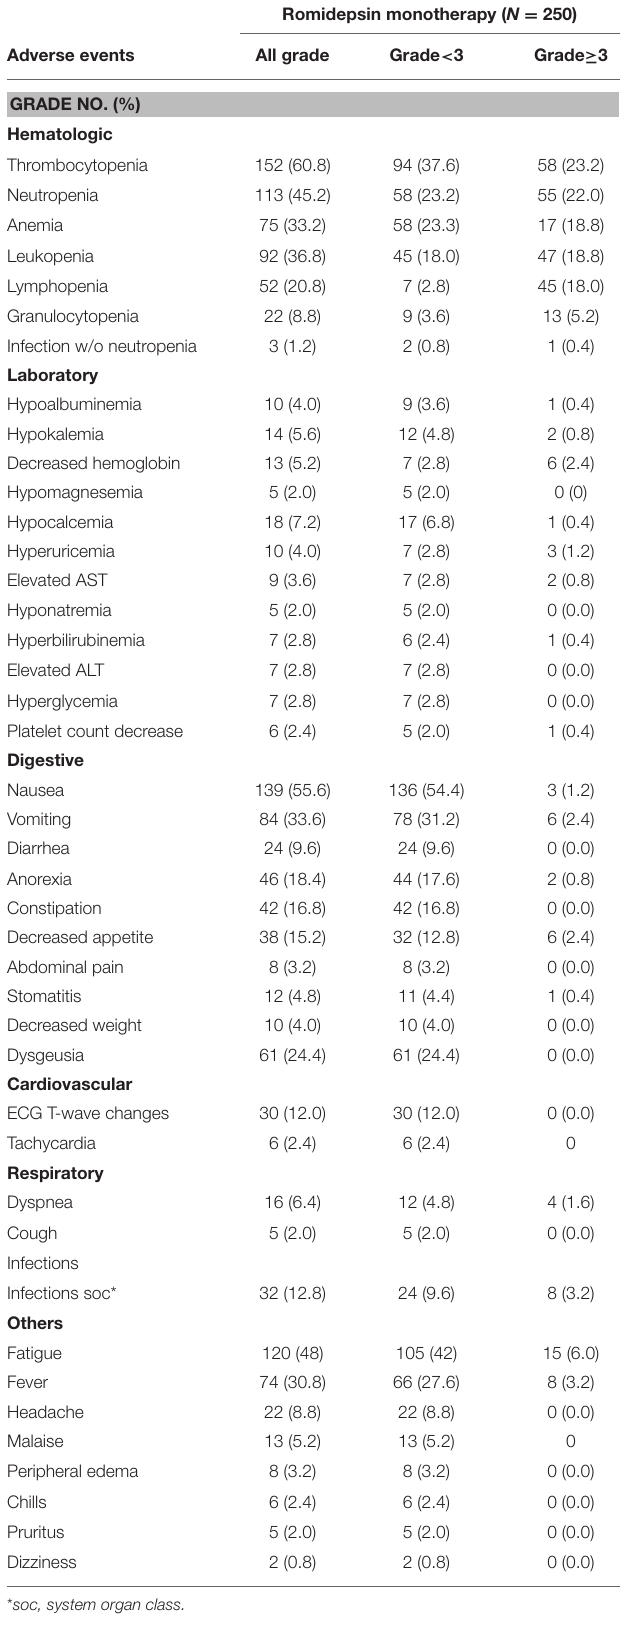
TABLE 2B | Treatment-related adverse events. Romidepsin monotherapy ( N =